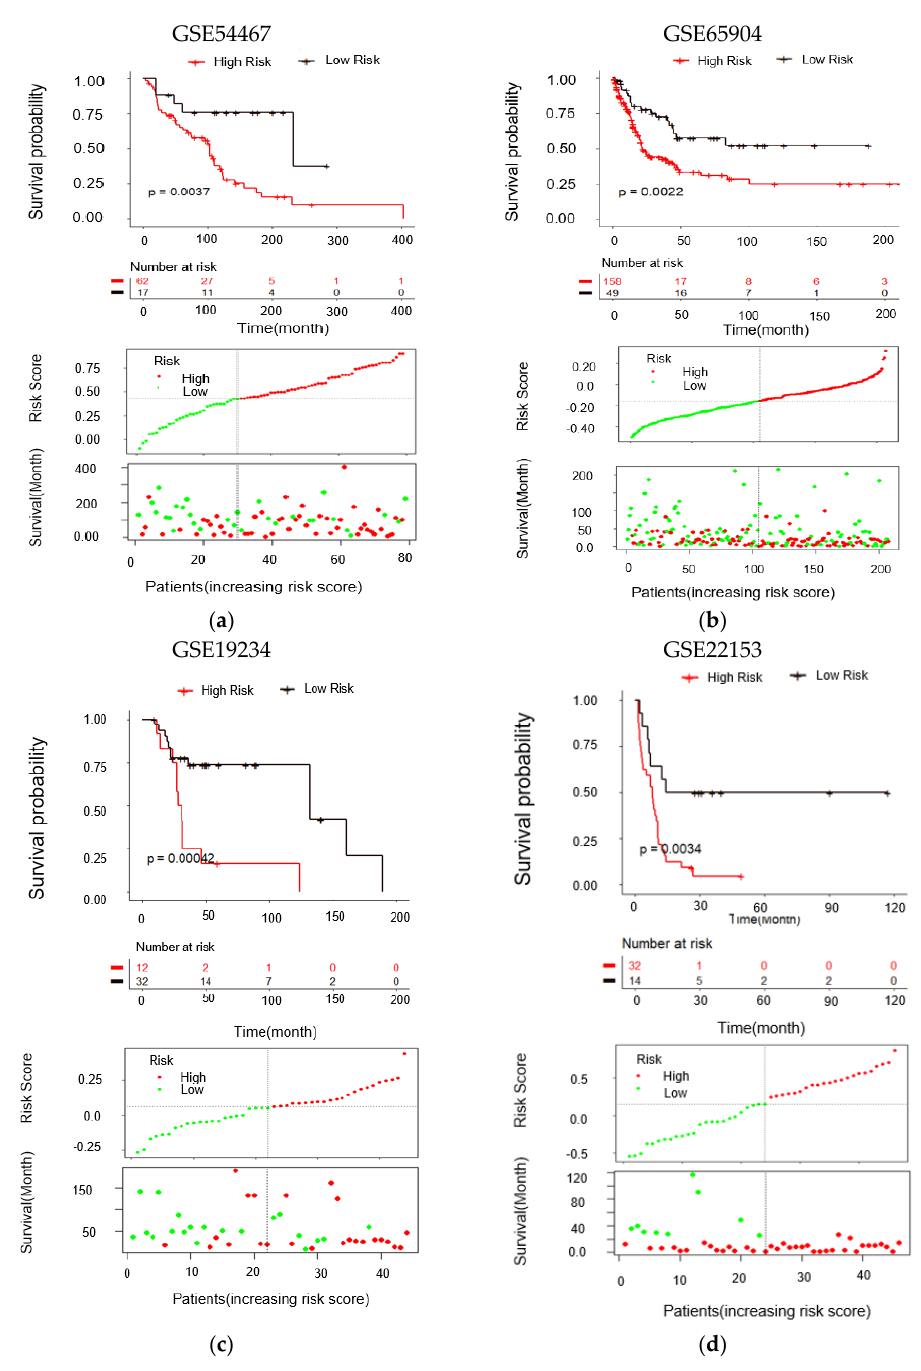
Figure 5. Validation of the gene signature in different melanoma transcriptome datasets. ( a – d ) Kaplan–Meier analysis, distribution of risk score of validation datasets I to IV, respectively. The black dotted line indicates optimum cutoff dividing patients into low–risk and high–risk subtypes. Statistical significance was determined by the log–rank test.